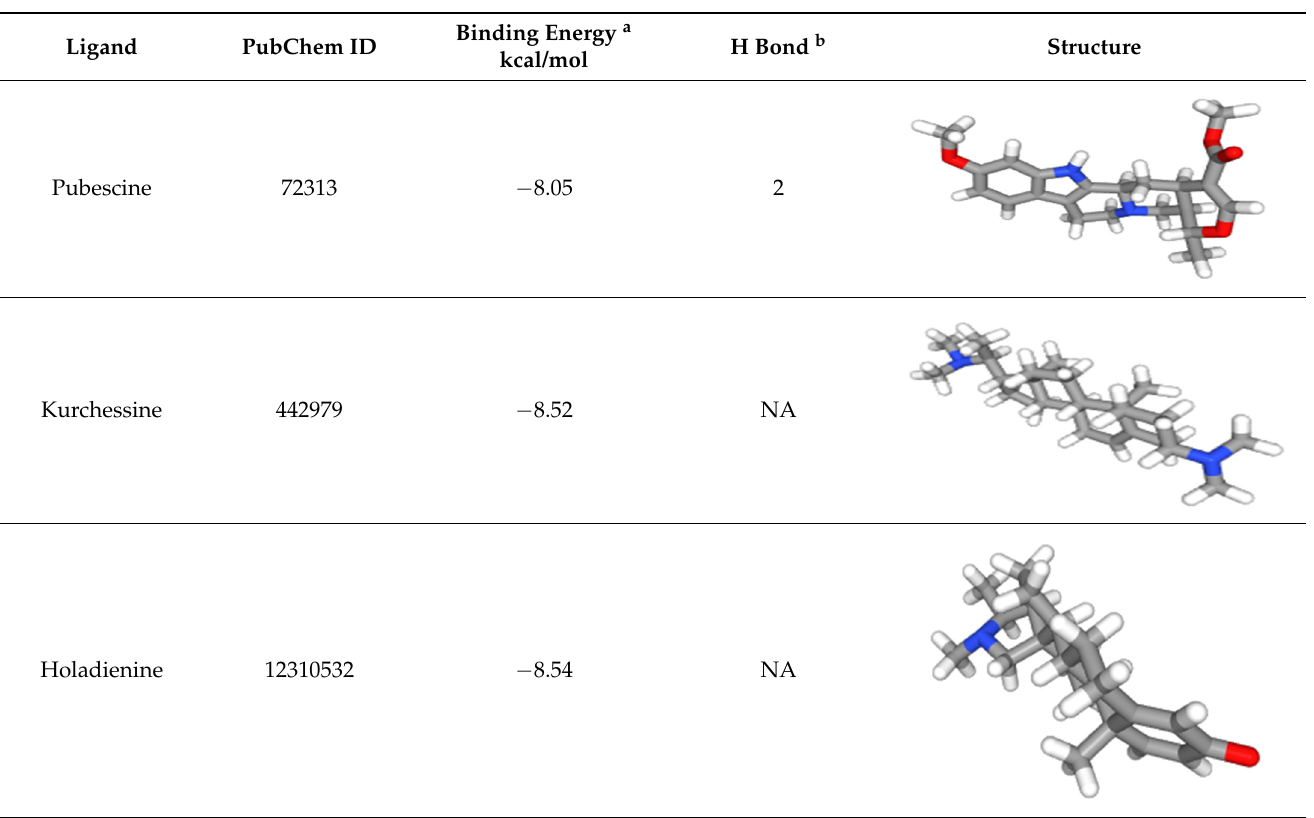
Table 2. Ligands used for docking with ECD. a Binding energy values of the test ligands, b number of hydrogen bonds formed with the ligands.